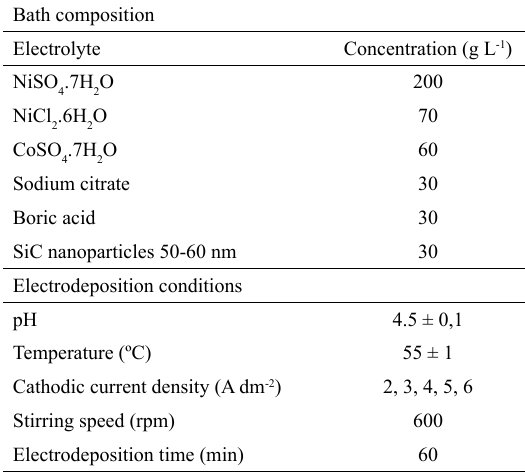
Table 1. Electrodeposition parameters for the preparation of Co-Ni/SiC